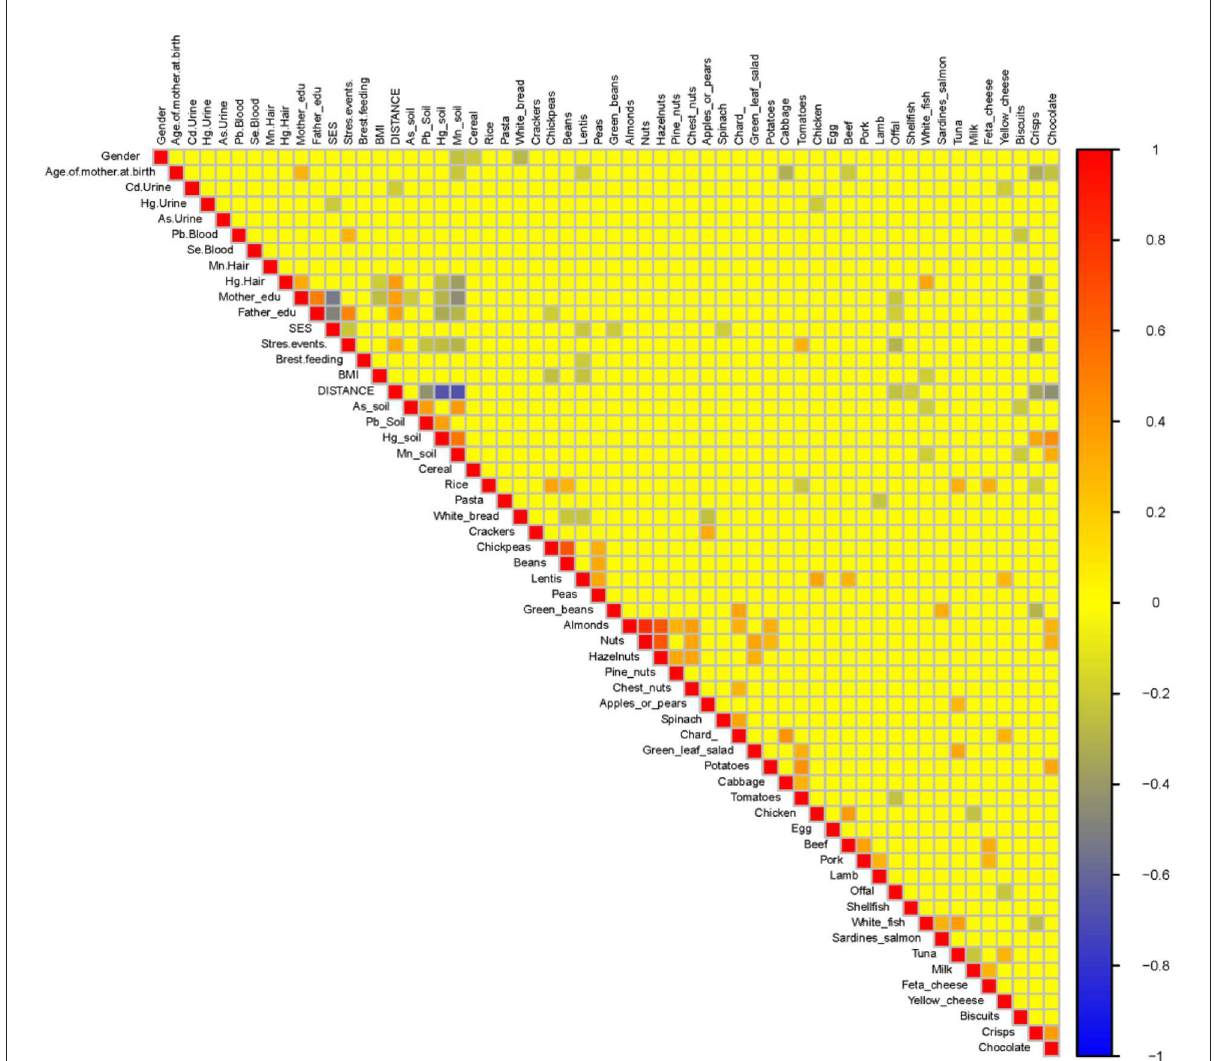
FIGURE10 Exposure parameters heatmap for the HERACLES cohort. The distance of the living address found to be highly negatively associated with the concentrations of Hg and Mn in soil. In addition, white fish consumption is highly correlated with the concentrations of Hg in hair. The significance of these results is associated with the impact of exposure to Hg and Mn on children neurodevelopment. The exposure levels on Hg and Mn are correlated with most of the WISC IV